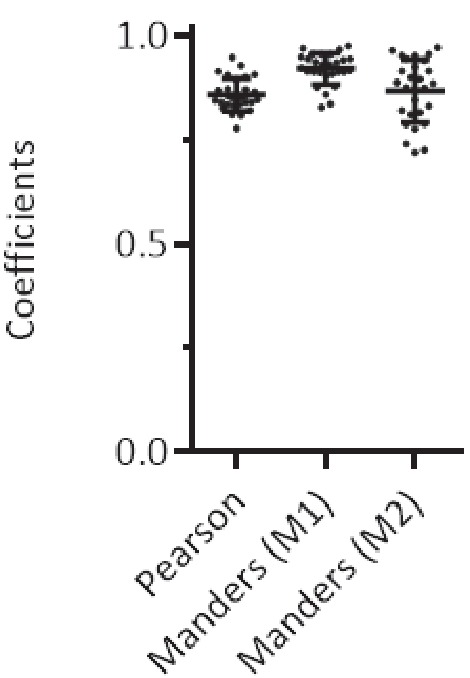
Colocalization of altDDIT3 with DDIT3.Scatter plots of Pearson’s Correlation Coefficient and Manders’ Correlation Coefficient after Costes’ automatic threshold (p-value<0.001, based on 1000 rounds of Costes’ randomization colocalization analysis). M1 is the proportion of altDDIT3GFP signal overlapping DDIT3mCherry signal and M2 is the proportion of DDIT3mCherry signal overlapping altDDIT3GFP. Error bars represent the mean ±SD of three independent experiments (28 cells).